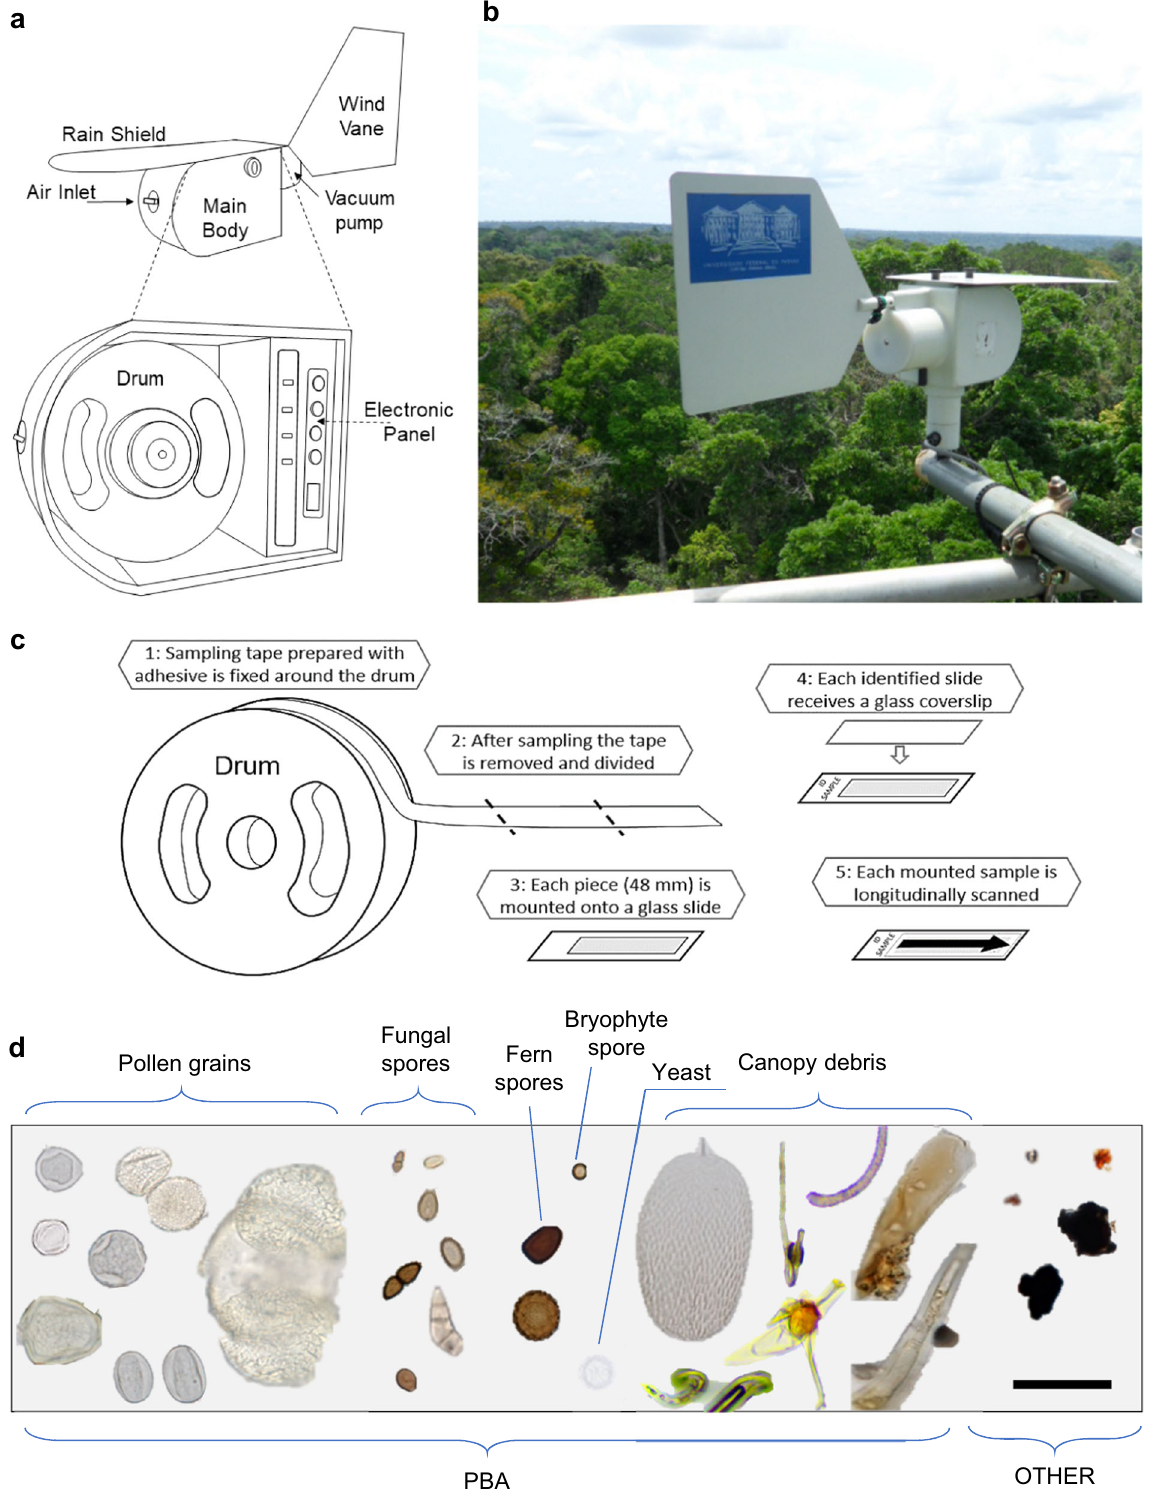
Fig. 6 Equipment and method of sampling. a Drawing scheme of the Burkard Volumetric Spore Sampler describing the parts attached to the main body, with the internal view in detail showing the rotating drum; b Picture of the sampler attached to the tower by a metallic support allowing free rotation according to the wind direction; c Scheme of the steps followed during sampling: (1) sampling tape preparation with adhesive along the entire surface and fi xation on the side of the rotating drum, (2) removal of the tape after sampling and separation